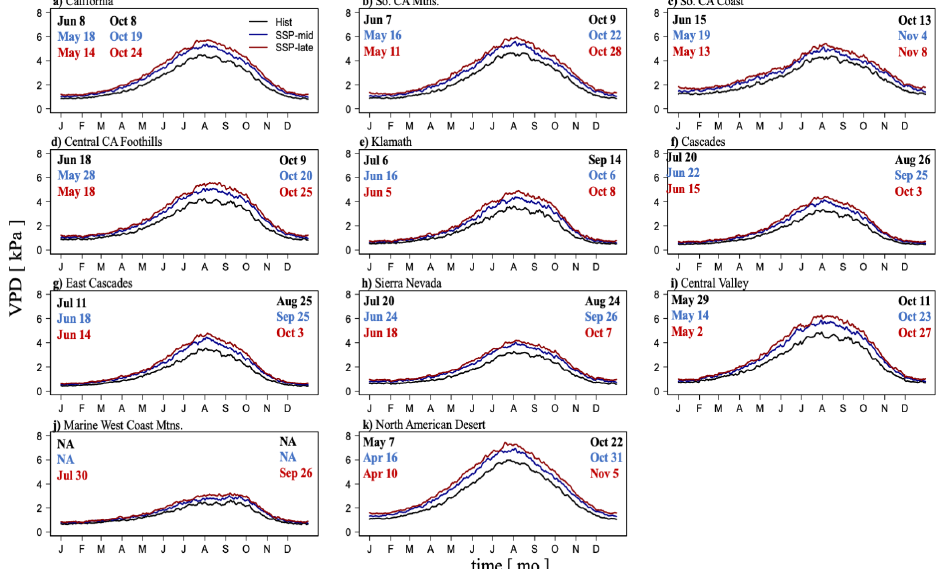
Figure 10. Thirty-year average Julian day VPD value by ecoregion. The black, blue, and red lines represent the historical, mid-century, and late-century averages, respectively. The color-coded text shows the average date for each respective time period that VPD exceeds ( left ) and falls below ( right ) a value of 3. ( a ) California; ( b ) Southern California Mountains; ( c ) Southern California Coast; ( d ) Central California Foothills; ( e ) Klamath; ( f ) Cascades; ( g ) East Cascades; ( h ) Sierra Nevada; ( i ) Central Valley; ( j ) Marine West Coast Mountains; ( k ) North American Desert. Units: kPa. Julian day climatologies of FWI indicated that the average summer peak FWI value Fire 2022 , 5 , x FOR PEER REVIEW will increase, and the fire season, defined here by the onset of average FWI greater than 15, will begin earlier and end later in the mid- and late-century periods relative to the historic period. However, the effect of climate change on the growth of the fire season was greater for VPD than it was for FWI (Figure 11). The greatest impact was to the onset of the fire season, with late-century average FWI exceeding a value of 15 anywhere from 6 days (SCC) to one month (NAD) before the historical average.